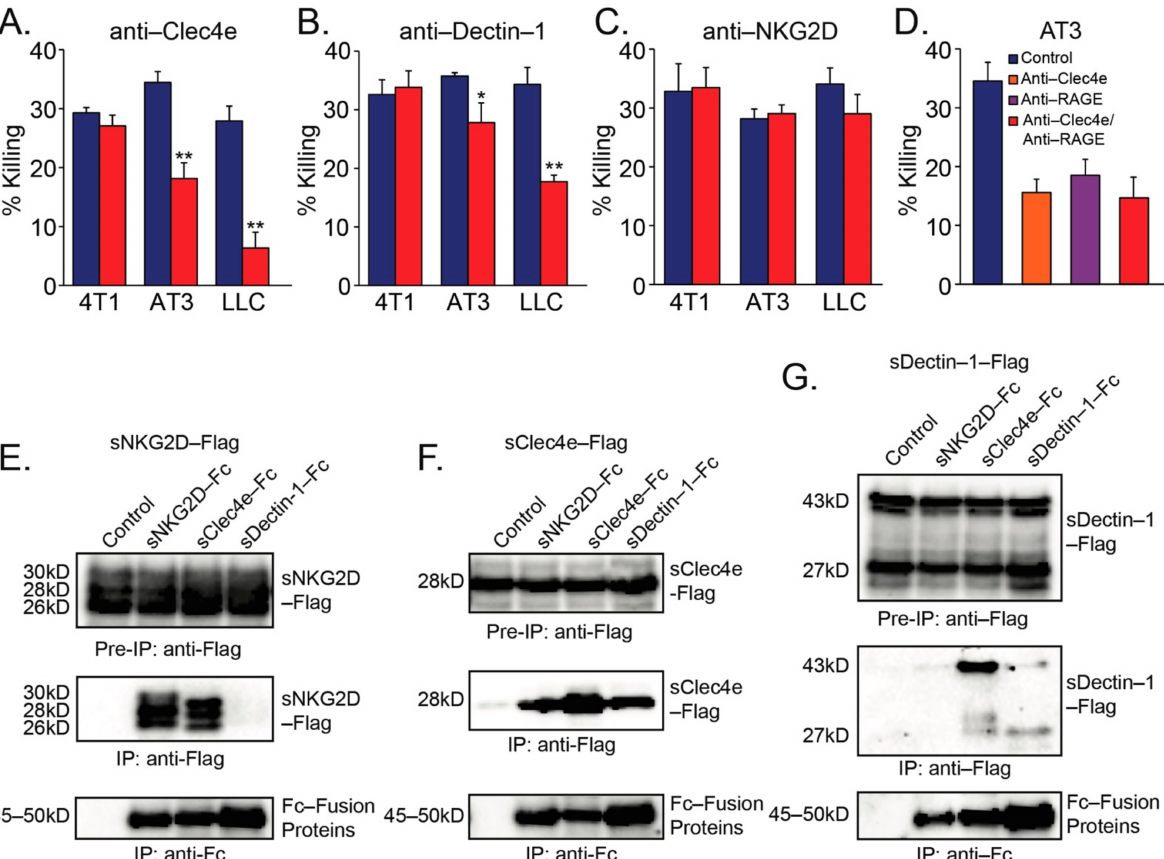
Figure 2. ( A ) Inhibition of neutrophil cytotoxicity using blocking antibodies to Clec4e. ( B ) Inhibition of neutrophil cytotoxicity using blocking antibodies to Dectin-1. ( C ) Blocking antibodies to NKG2D did not perturb neutrophil cytotoxicity. ( D ) The concomitant presence of both anti-Clec4e (1 µ g/mL) and anti-RAGE (1 µ g/mL) did not cause a stronger inhibition of neutrophil cytotoxicity towards AT3 cells than either antibody alone. ( E – G ) Immunoprecipitation of C-type lectin receptor Fc fusion pro- teins in the presence of sNKG2D-Flag ( E ) sClec4e-Flag ( F ) or sDectin-1-Flag ( G ) Pre-IP = Cell extract samples prior to immunoprecipitation. IP = Immunoprecipitated samples. * p < 0.05; ** p <